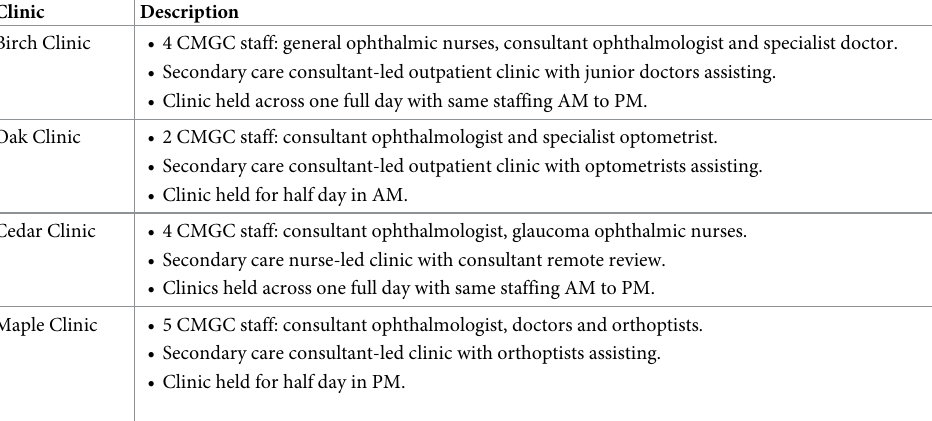
Table 2. Eye clinic site